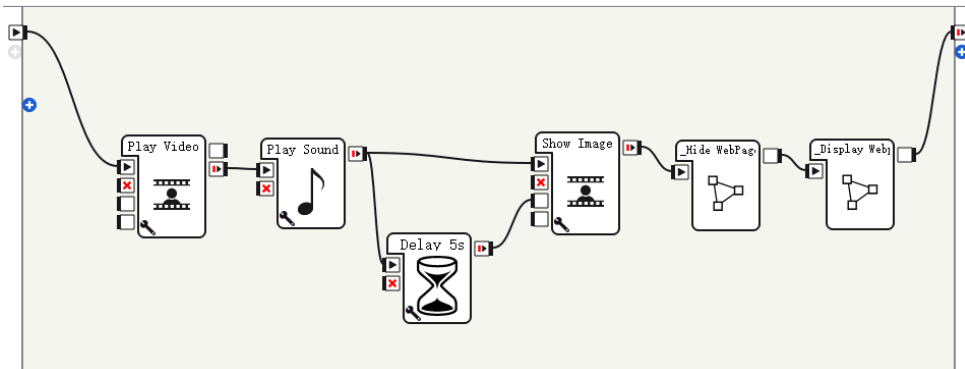
Figure 6. Choregraphe programming interface.